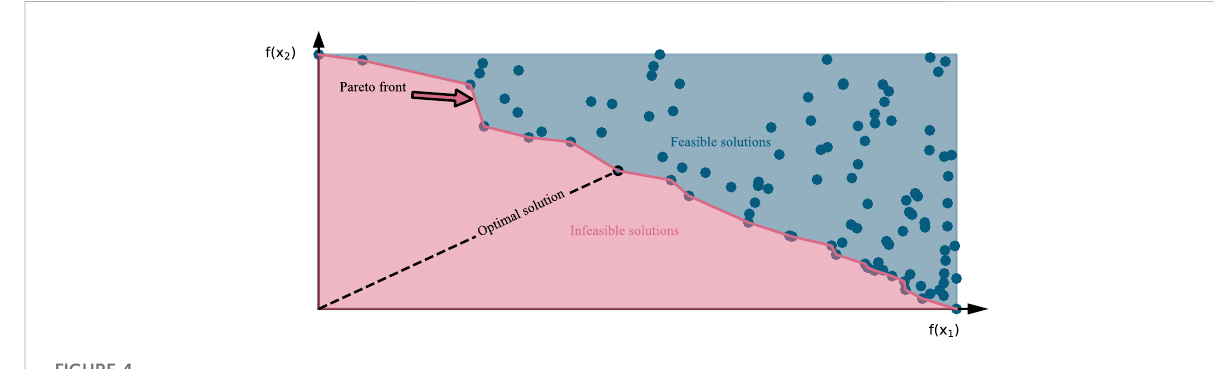
FIGURE 4 Qualitative graph of a Pareto front for a multi-objective optimization with two objective functions, f (x 1 ) and f (x 2 ).